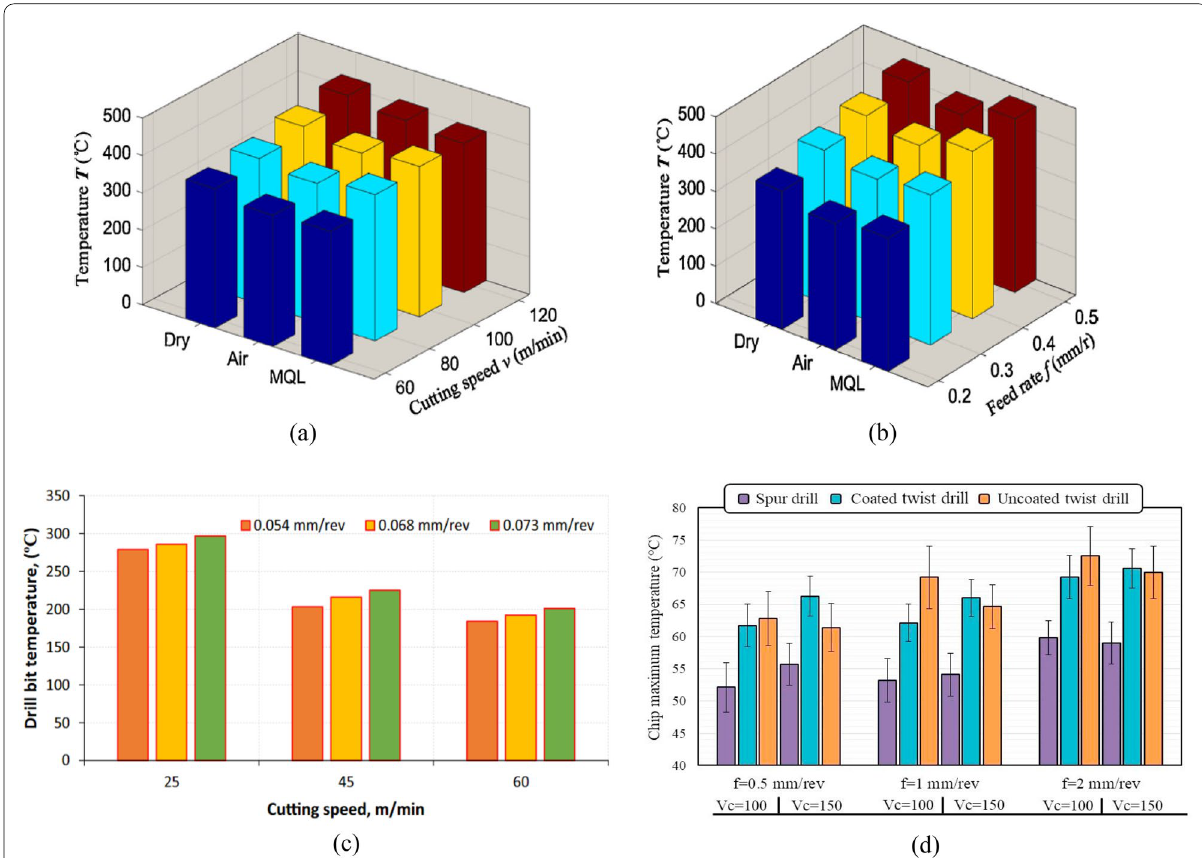
Figure 14 Temperature for different drilling conditions: a , b When drilling Aluminum alloy, c When drilling Ti-6Al-4V, d When drilling Magnesium alloy [3, 66,